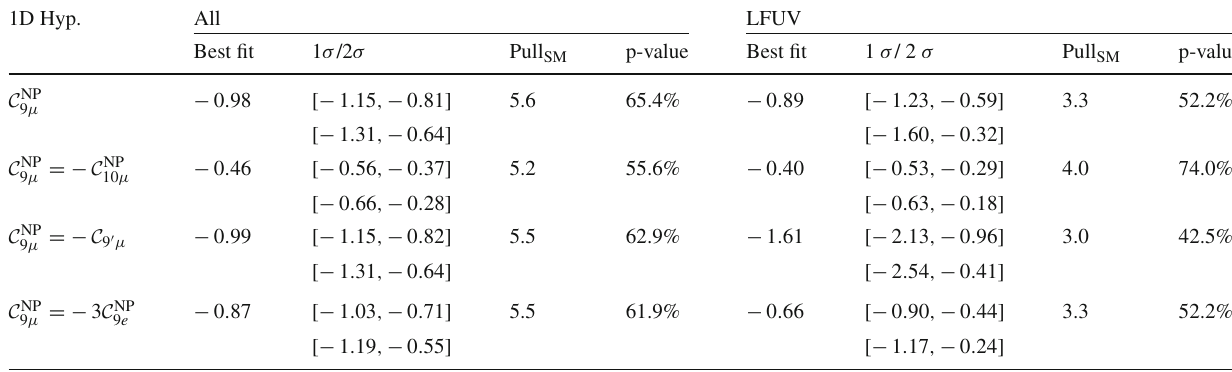
= − C , C NP = C ) , 2: 9 (cid:4) μ 10 (cid:4) μ 9 μ 10 μ , C = − C 9 (cid:4) μ 10 (cid:4) μ 9 μ